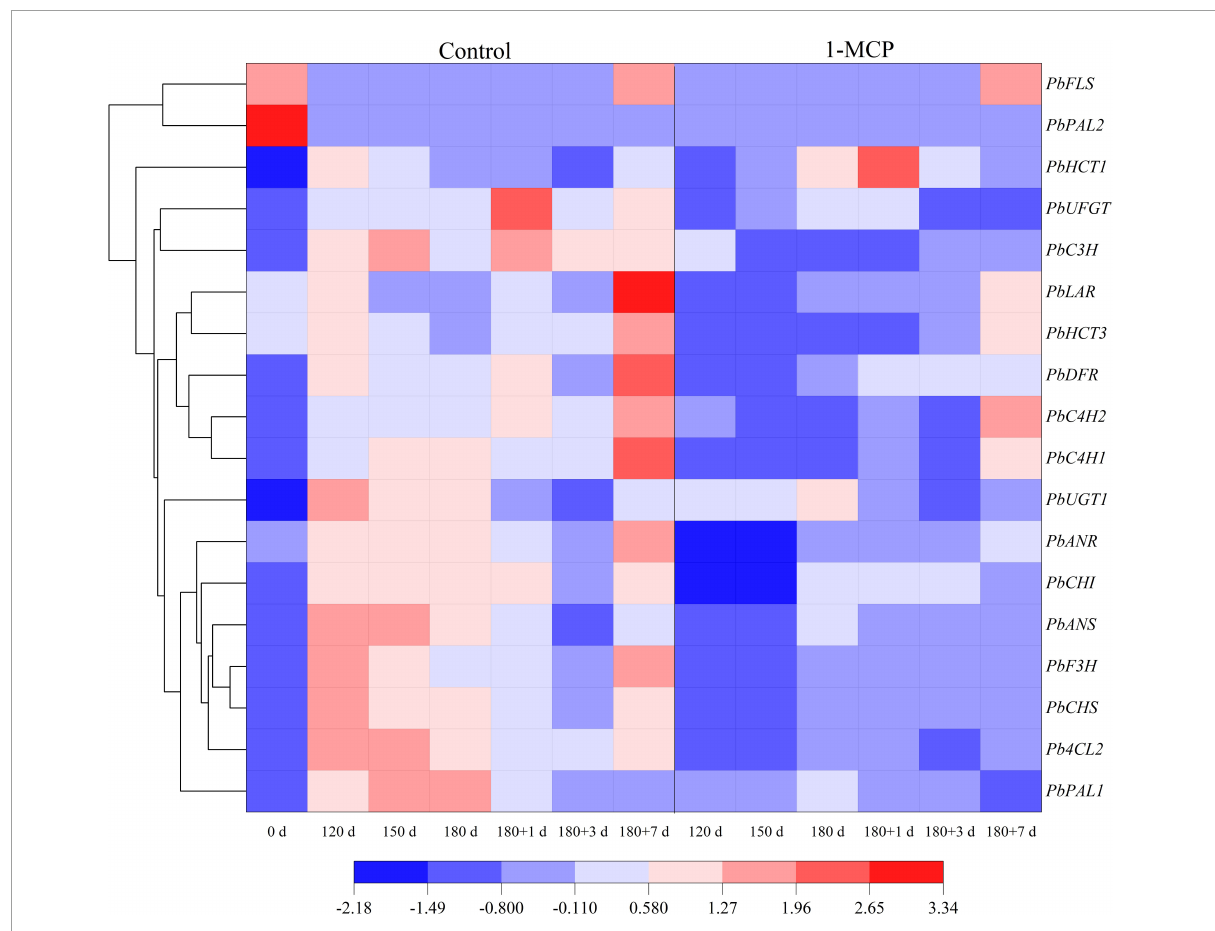
FIGURE5 Effect of 1-MCP on phenolic acid and flavonoid synthesis-related genes expression of the peels in “Yali” pear. 180 + 1, 180 + 3, and 180 + 7 indicated Days 1, 3, and 7 at shelf life after 180 days of cold storage,